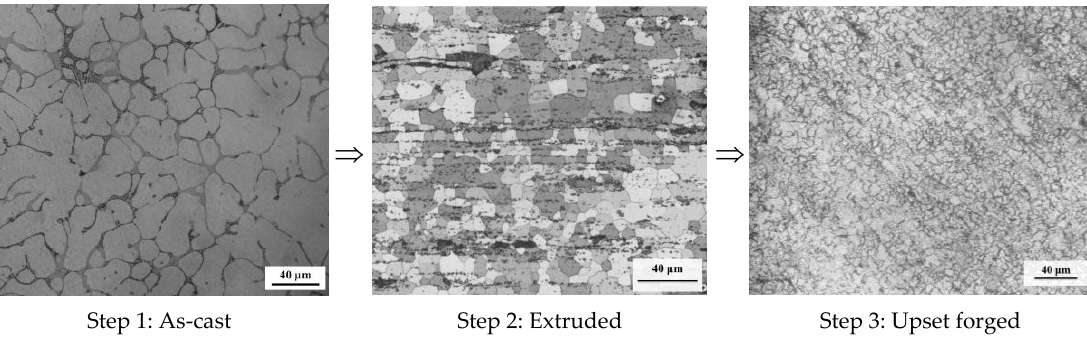
Figure 10. Microstructural changes in continued processing steps of the ABaX422 magnesium alloy.